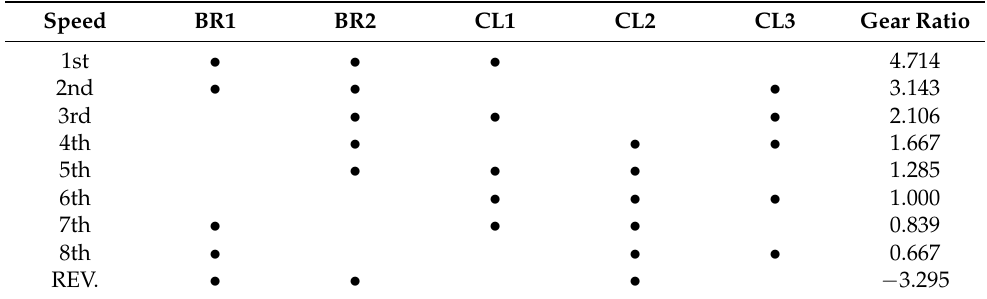
Table 1. Actuation scheme of brakes and clutches for 8 forward and 1 reverse speeds [28]. Reprinted with permission from ref. [28]. Copyright 2013 SAE International.